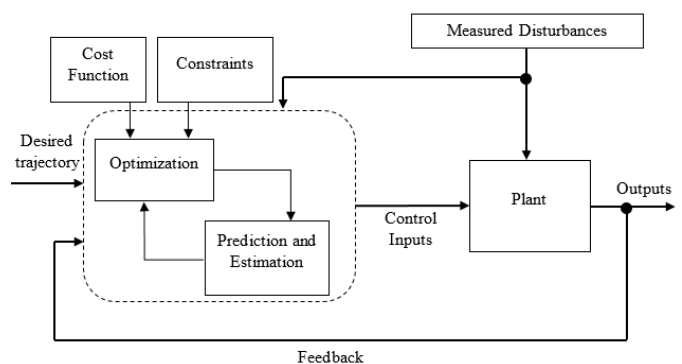
Figure 2. A block diagram of MPC workflow.